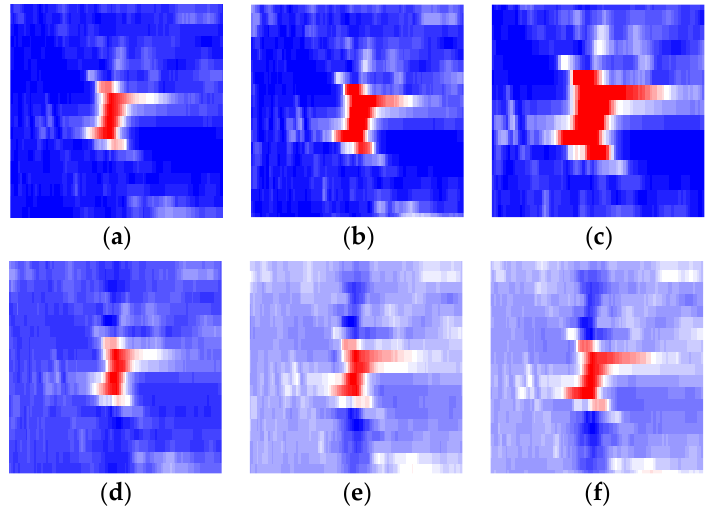
Figure 7. Examples of positive sample. ( a ) Tracking target image; ( b ) image after 1.5 times stretching;